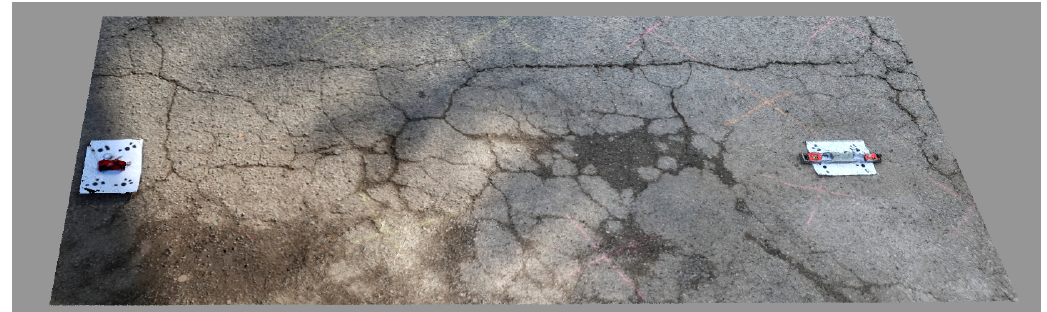
Figure 8. Model produced by imagery from Huawei P20 Pro.